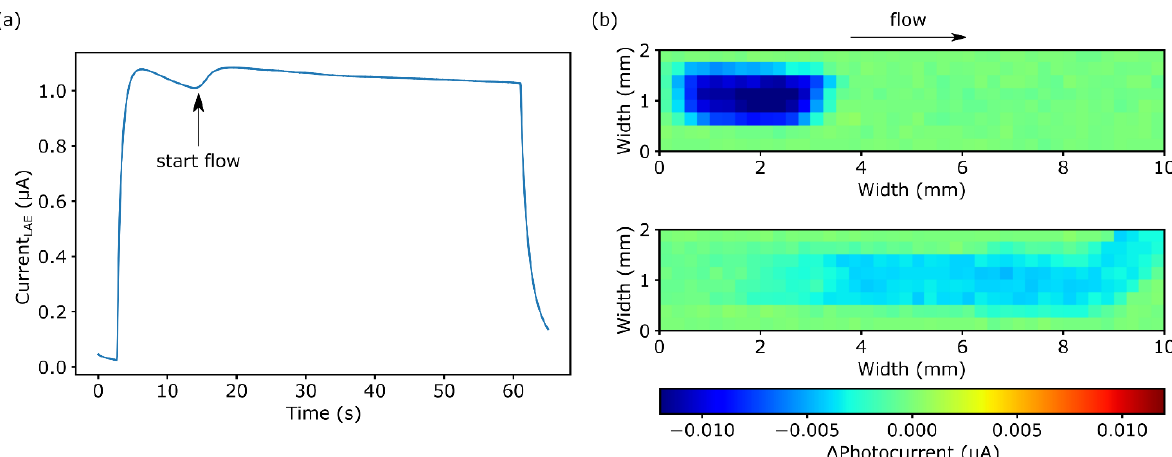
Figure 5. ( a ) Transient photocurrent signal for 60 s of illumination. ( b ) Chemical images of static (top) and dynamic (bottom) pH changes inside the microfluidic channel induced by the LAE.